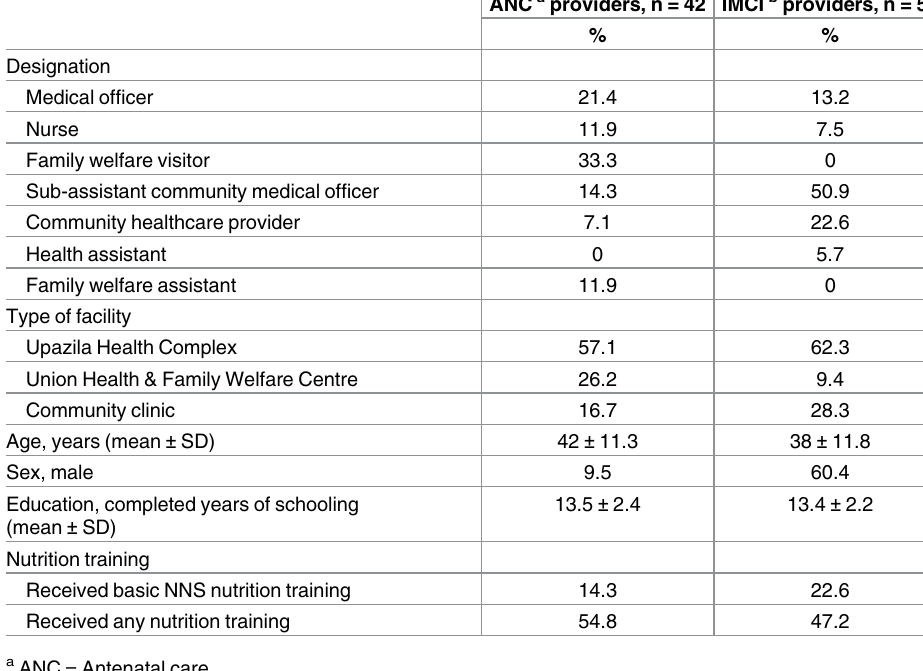
Table 3. Characteristics of healthcare providers delivering antenatal care and care of sick under-five children at different health